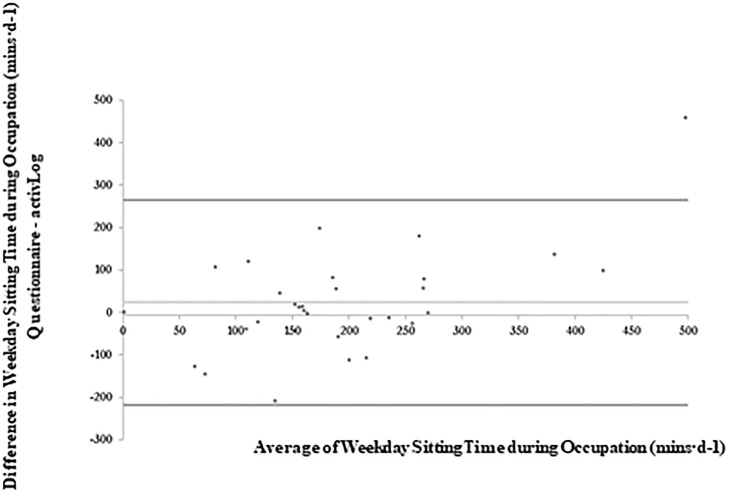
Bland-Altman plots of absolute agreement of sitting time during occupational time (weekdays) derived from the questionnaire with the equivalent variable derived from the criterion measure (combination of AP3M determined sedentary time and the domain specific log).